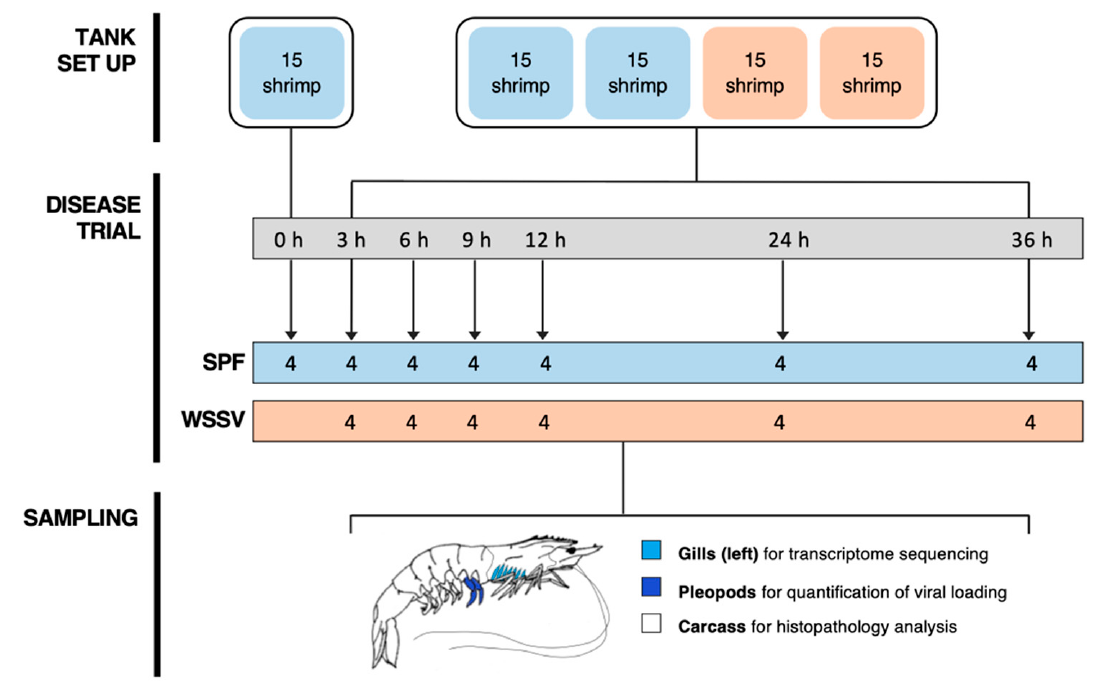
Figure 1. Schematic of the WSSV injection trial experimental set-up and sampling. Pacific whiteleg shrimp were randomly allocated into two groups. At zero hours, four control shrimp were sampled from a separate tank to provide a time-zero histological control reference. The remaining shrimp were injected with either specific-pathogen-free (SPF) or WSSV-infected shrimp inoculum. Four shrimp (two per treatment tank) were sampled from each treatment group at subsequent timepoints: 3, 6, 9, 12, 24, and 36 h. At each sampling point, gills from the left side of the shrimp were dissected and snap-frozen for transcriptome sequencing. The two most anterior pleopods were sampled to quantify viral loading, and the remaining carcass was fixed for histological